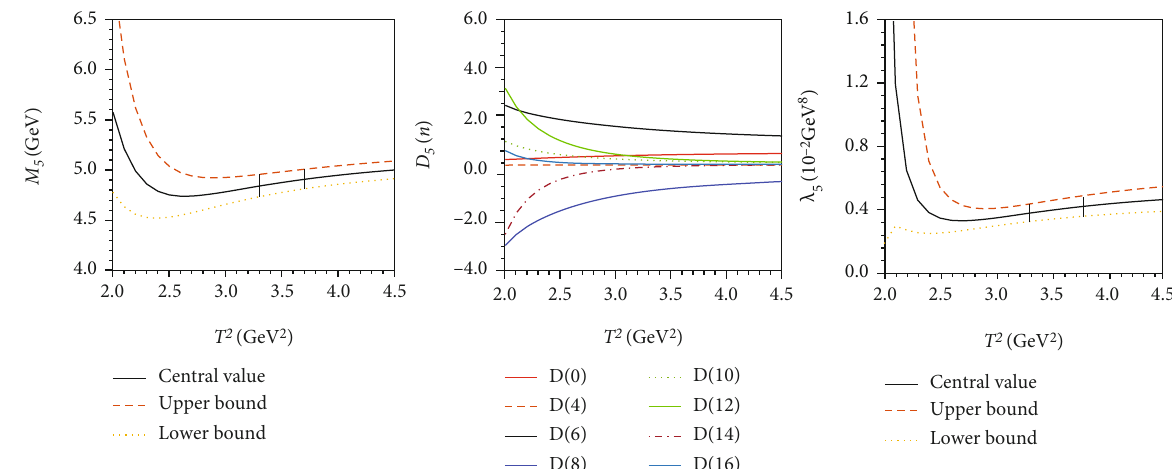
− T 2 for (a), dashed curve is drawn from the upper values of the input parameters and dotted : M 5 5 ð n Þ − T 2 for (b); λ − T 2 for (c), dashed curve is drawn from the upper values of the input parameters 5 5